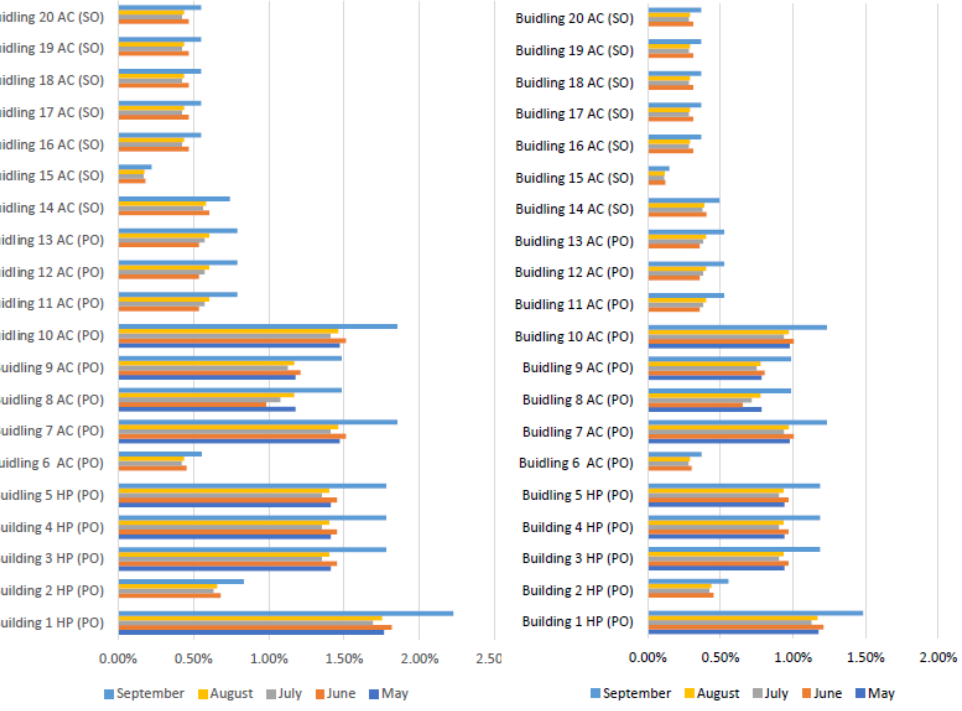
Figure 17. Daily savings obtained with application of DR strategies—best-case vs. worst-case scenario (PO, permanent occupancy; SO, seasonal occupancy).